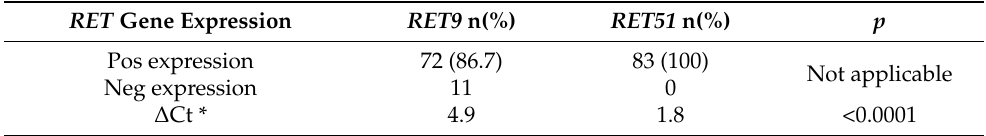
Table 1. RET9 and RET51 isoforms expression in our series of 83 MTC cases.